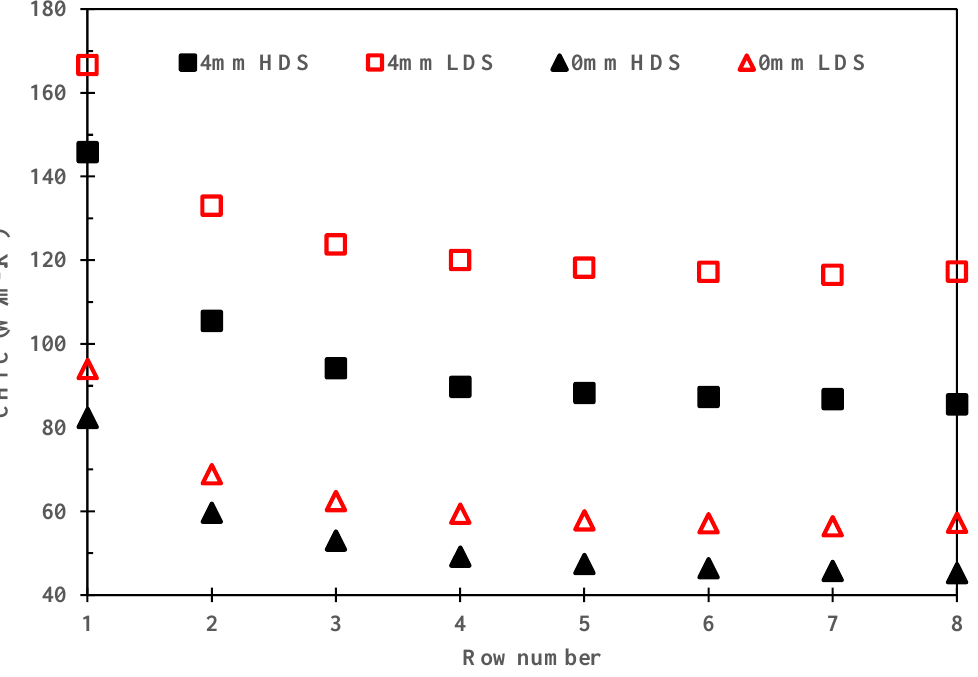
Figure 11. CHTC values for two brick surface roughness levels for the HDS and LDS bricks. The ratios ( α ) of the CHTC of the LDS to that of the HDS for different brick surface roughness levels are presented in Figure 12. In row 1, the variation in is less than 1% for all brick roughness values due to the large turbulence effect at the inlet of the brick settings. In the flow transition region between rows 2 and 5, the ratio ( α ) increases as the row number increases. The CHTC ratio ( α ) of the smooth bricks is lower than for the roughened bricks for rows 2 to 7. For the fully developed flow in rows 6 and 7, the ratio ( α ) of the smooth bricks is about 1.23, and for brick surface roughness levels of 1 to 4 mm,